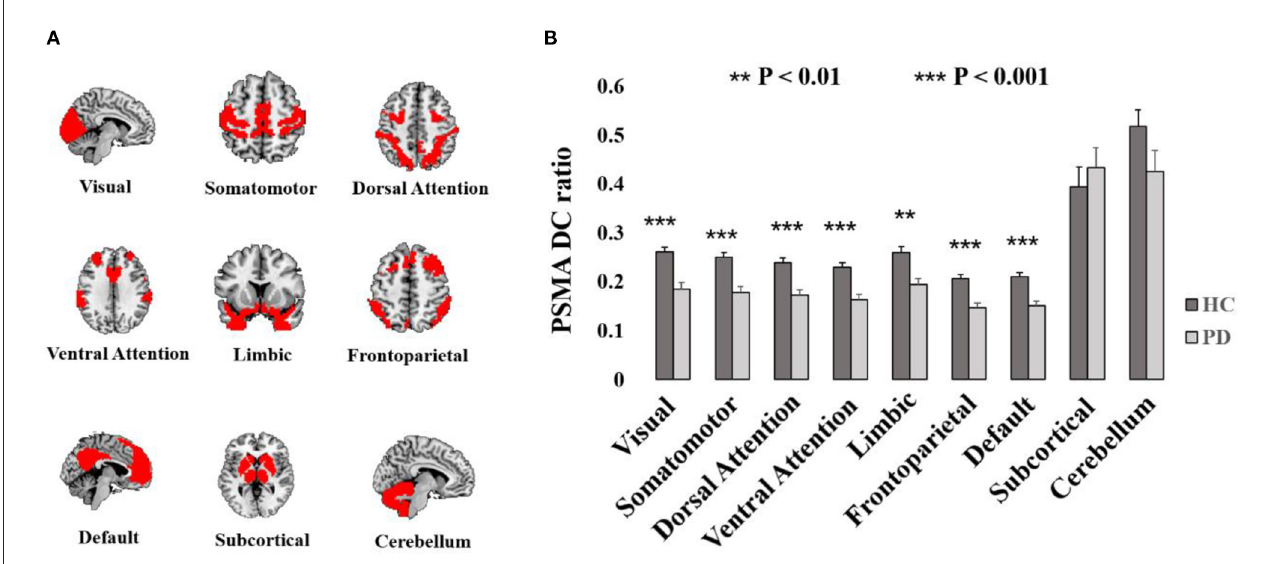
FIGURE2 Display of nine networks and the group difference of PSMA DC ratio with the networks. (A) Illustrates the spatial pattern of Yeo’s seven networks and the subcortical network as well as the cerebellum. (B) Shows the bar plots of PSMA DC ratio differences. Significant reduced PSMA DC ratio could be obtained in Yeo’s seven networks ( P -values < 0.01). Error bars represent standard errors.